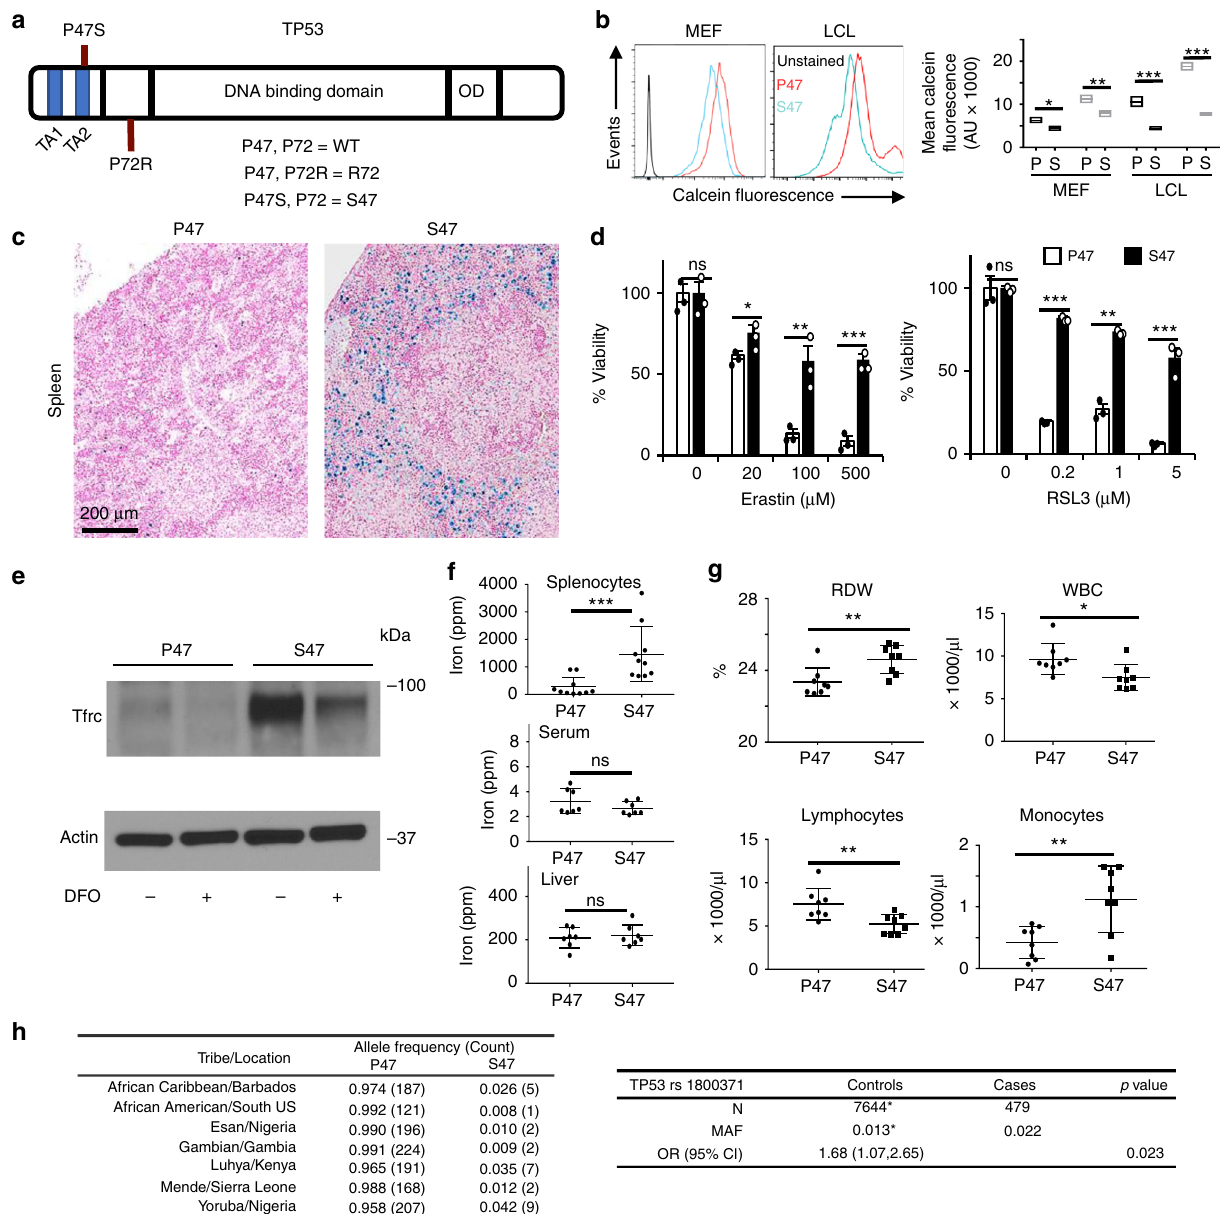
Fig. 1 Iron accumulation in mice containing the S47 variant. a Domain model of TP53 showing the positions of S47 P47 and R72 SNPs studied in this paper. b Iron levels in P47 and S47 human lymphoblastoid cell lines and mouse embryonic fi broblasts measured by loss of calcein fl uorescence. Mean fl uorescence intensity re fl ects iron levels in untreated (black) or 100 μ M DFO-treated (gray) MEFs and LCLs ( n = 3 biological replicates). Error bars represent means± s.e.m. ** P < 0.01, * P < 0.05, by unpaired Student ’ s t test, relative to P47 mice. c Formalin- fi xed sections of male S47 and P47 mouse spleens stained by Prussian Blue; representative images are of six biological replicates per group with 5 – 7 fi elds per sample. d Percent viability of P47 (white) and S47 (black) monocyte-derived macrophages, 48 h after treatment with ferroptosis inducers Erastin and RSL3. ( n = 3 biological replicates each with three technical replicates). Error bars represent means ± s.e.m. *** P < 0.001, ** P < 0.01, * P < 0.05, ns — not signi fi cant; by unpaired Student ’ s t test. e Relative levels of the iron transport protein Tfrc in P47 and S47 mouse MDMs measured by immunoblot with or without DFO treatment (representative blot of three technical replicates). f ICP-MS shows signi fi cantly higher iron content in S47 male mouse splenocytes ( n = 10 biological replicates). Error bars represent means ± s.e.m. *** P < 0.001, ** P < 0.01, * P < 0.05, ns — not signi fi cant; by unpaired Student ’ s t test, relative to P47 mice. g CBC pro fi les in S47 and P47 male mice ( n = 8 biological replicates). Error bars represent means ± s.e.m. ** P < 0.01, * P < 0.05, by unpaired Student ’ s t test, relative to P47 mice. h Allelic frequencies for the S47 SNP in populations of African descent; data are obtained from the 1000 Genomes Project (left panel). Associations between TP53 rs1800371 (S47) in individuals with high serum ferritin level and/or high saturated transferrin receptor in African Americans from the HEIRS database (right panel). (MAF = minor allele frequency, OR (95% CI) = odds ratio (95% con fi dence interval), * from 25 . Source data are provided as a Source Data fi